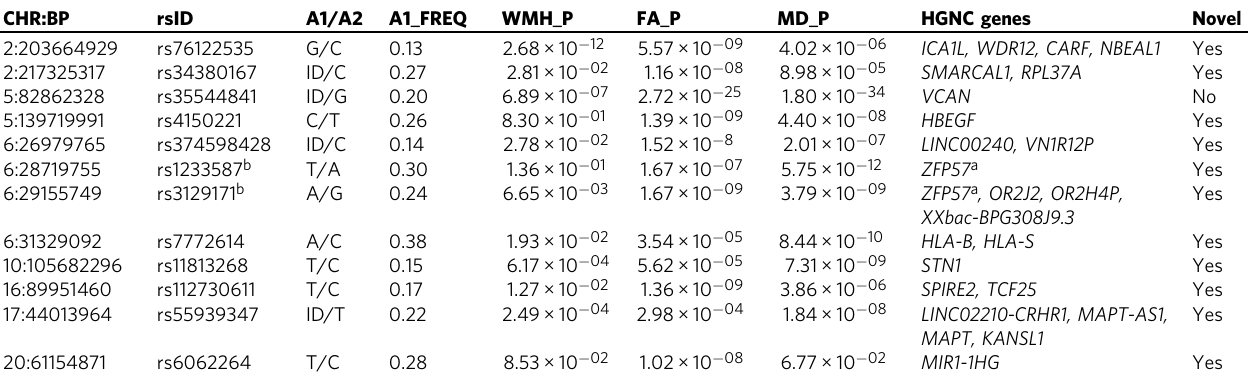
Table 2 Top association SNPs for independent loci for FA and MD GWAS.